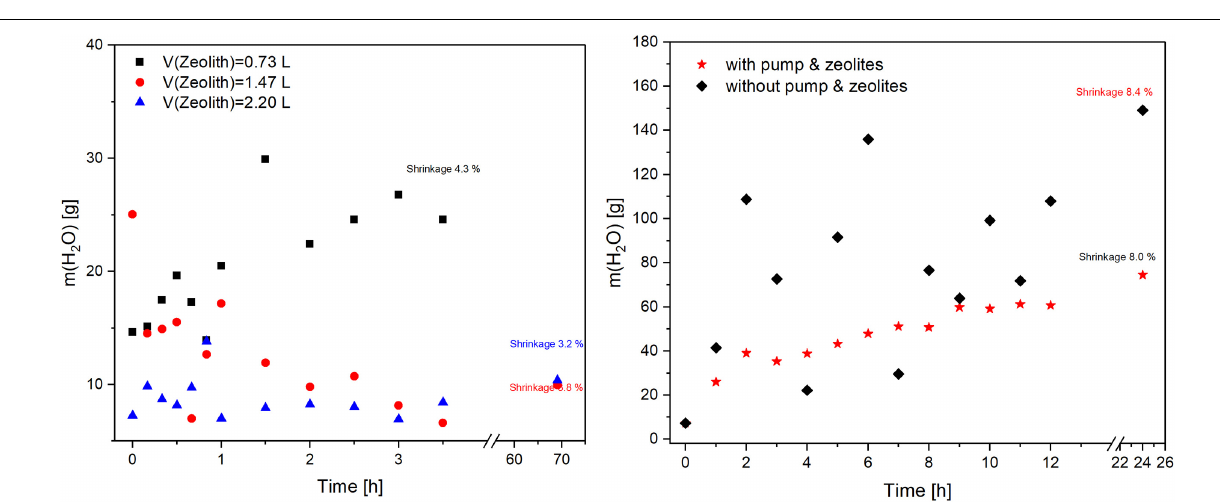
FIGURE 9 | (left) Water content in the solvent acetone as a function of the process time at 3 different volumes of zeolites; (right) Water content in the solvent acetone as a function of the process time and used setups.